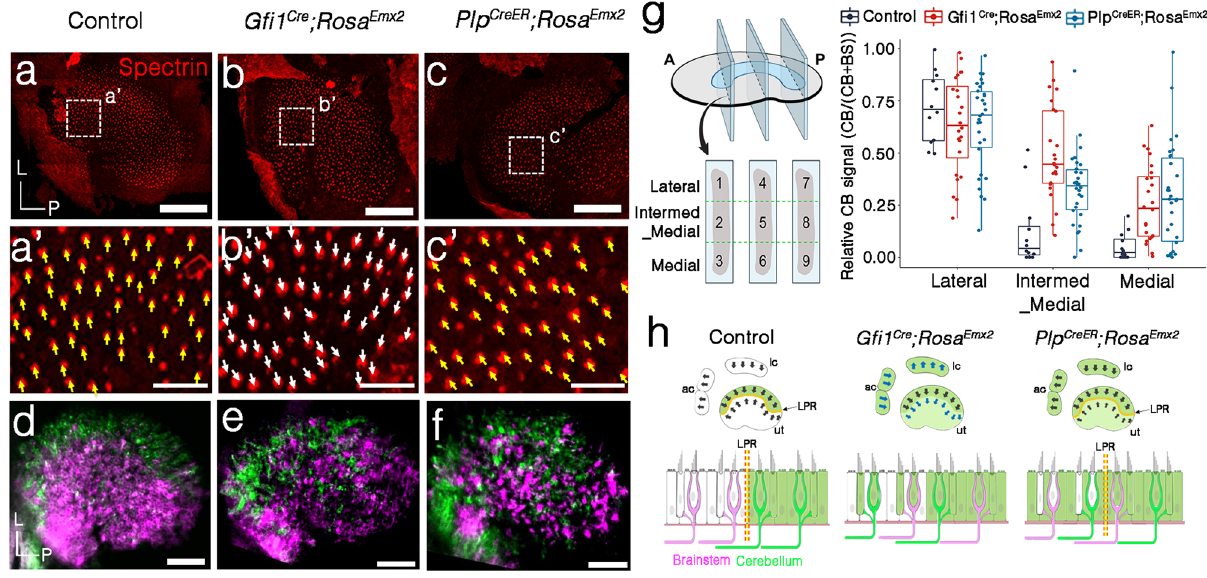
Fig. 5 | Afferent neuronal segregation pattern in the utricle is affected by ectopic Emx2 expression in either HCs or supporting cells. a – c ’ Anti- β spectrin stainingshowinghairbundleorientationinthemedialutricleistowardsthelateral, which is reversed in G fi 1 Cre ; Rosa Emx2 utricles ( b ’ , white arrows, n =3) but normal in Plp CreER ;Rosa Emx2 utricles( c ’ ,yellowarrows, n =5). d – f Neuronaldyetracingfromthe cerebellum (green) and brainstem (magenta) in control ( d , n =5), G fi 1 Cre ; Rosa Emx2 ( e , n =10) and Plp CreER ; Rosa Emx2 utricles treated with tamoxifen at E13.5 ( f , n =13). Neuronal dye tracing is not well segregated in G fi 1 Cre ; Rosa Emx2 ( e ) and Plp CreER ; Rosa Emx2 utricles ( f ) as in controls ( d ). g The reduction in relative cb signal from lateral to intermed_medial region was not signi fi cant for G fi 1 Cre ; Rosa Emx2 utricles ( n =8) but signi fi cant for Plp CreER ; Rosa Emx2 utricles ( n =10) (Dunn ’ s pairwise tests, G fi 1 Cre ; Rosa Emx2 , z =1.70 , p =0.09 ; Plp CreER ; Rosa Emx2 , z =4.29 , p =3.5E − 05). Compared